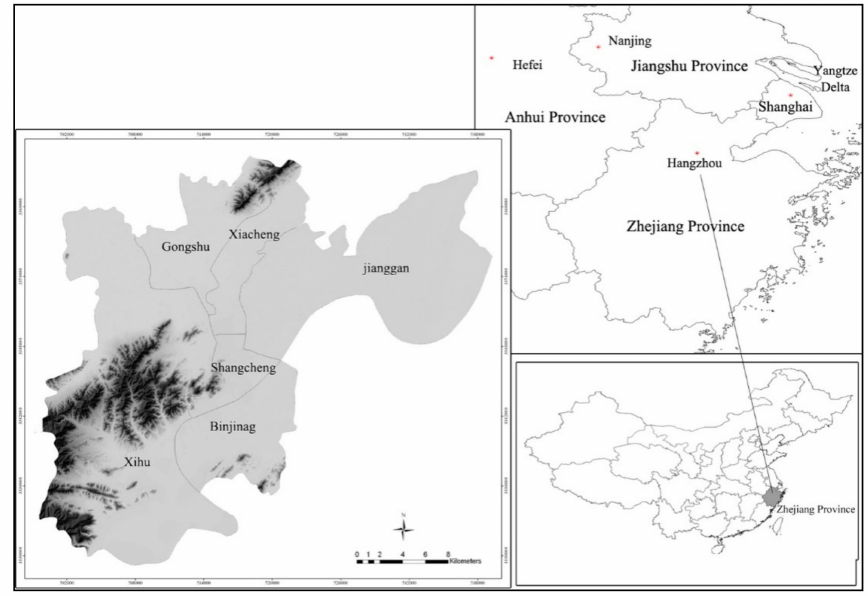
Figure 1. Location of Hangzhou City in Yangtze River